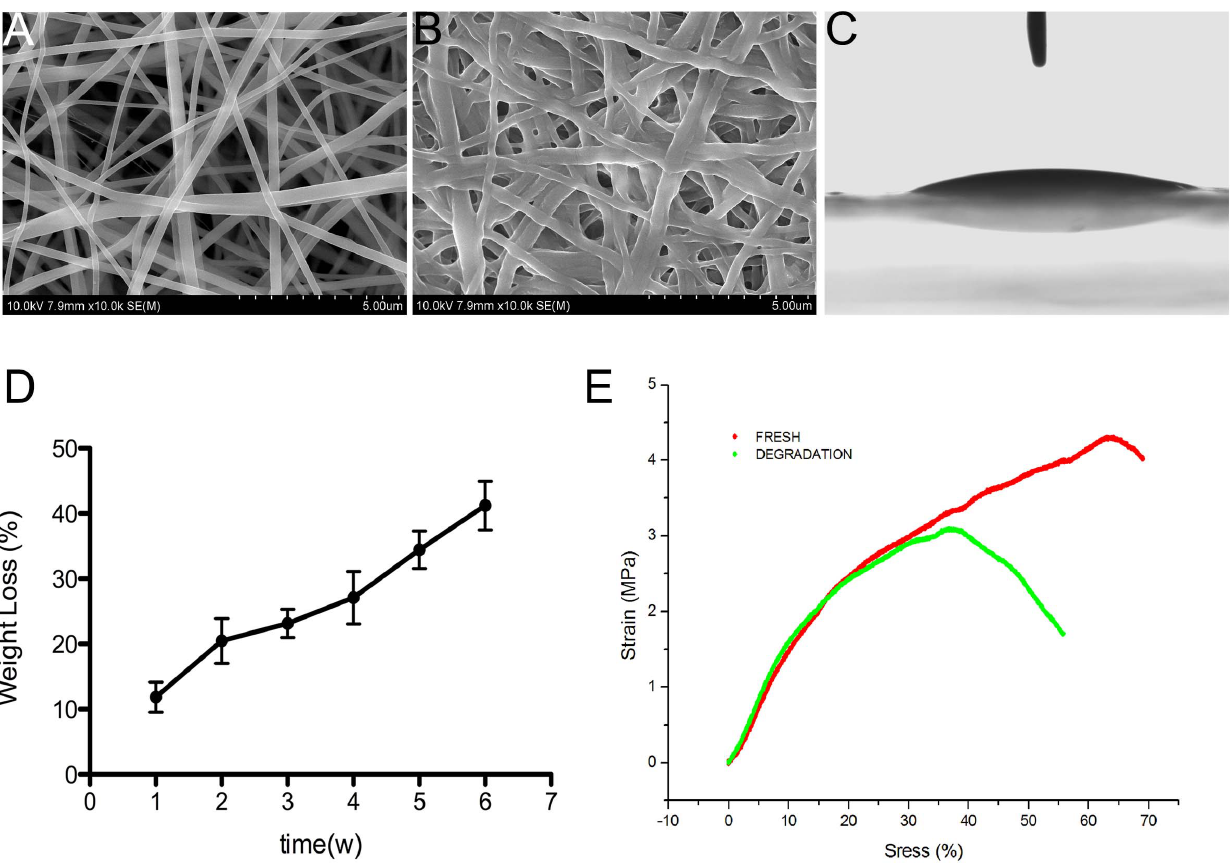
Figure 1. Scaffold characterization. ( A ) SEM images of the scaffold revealed a mesh-like nanofibrous structure. ( B ) SEM image of a scaffold degraded in PBS solution for 1 month. ( C ) Image of water droplet on the scaffold. ( D ) Scaffold weight loss during degradation. ( E ) Elastic curves of intact and 1-month degraded scaffolds in red and green, respectively.